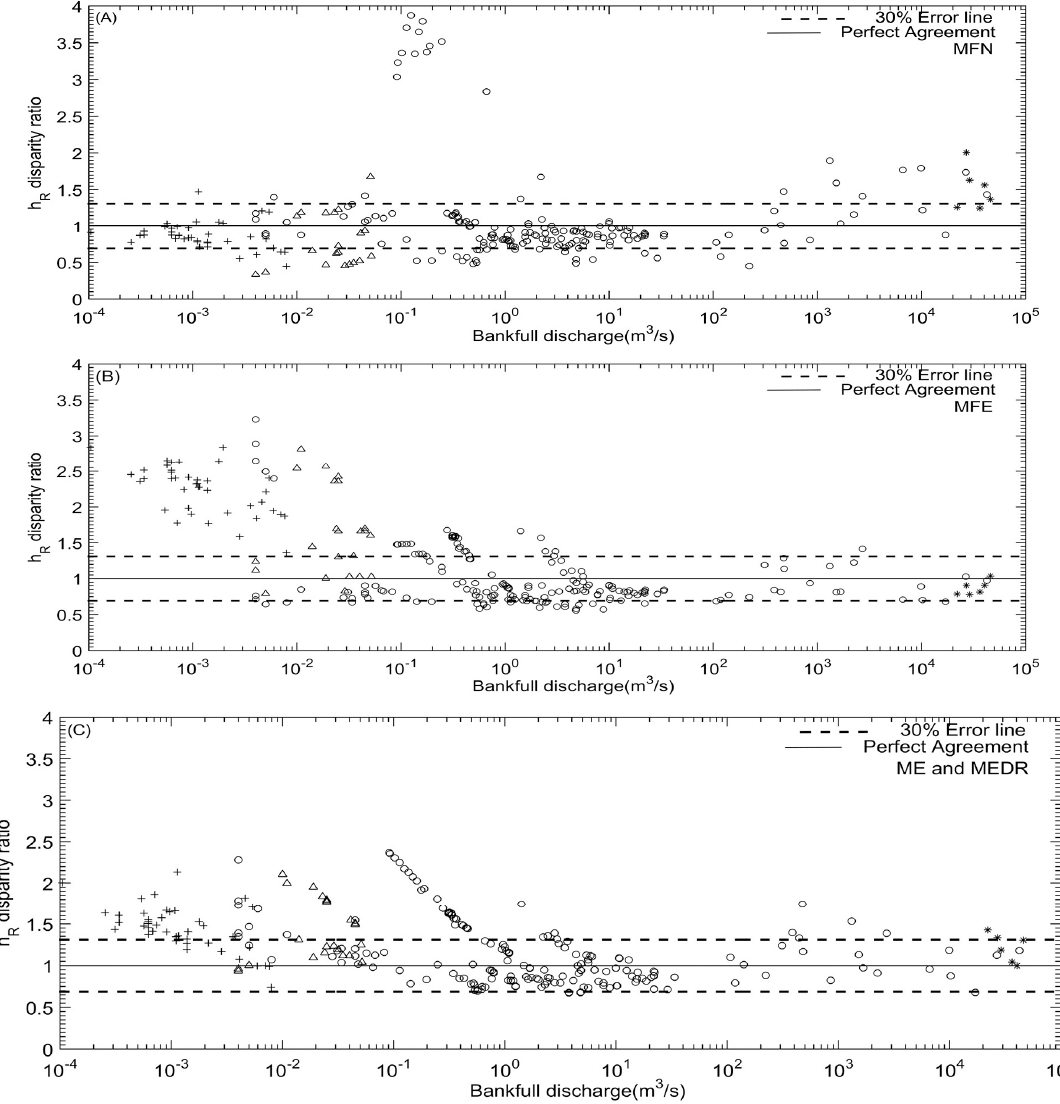
Figure 4. Scatter plot of disparity ratio h R against bankfull discharge for sand bed channels [27,45–47]. ( A ) MFN; ( B ) MFE; ( C ) ME and MEDR. Same legend as on Figure 1 applies here.